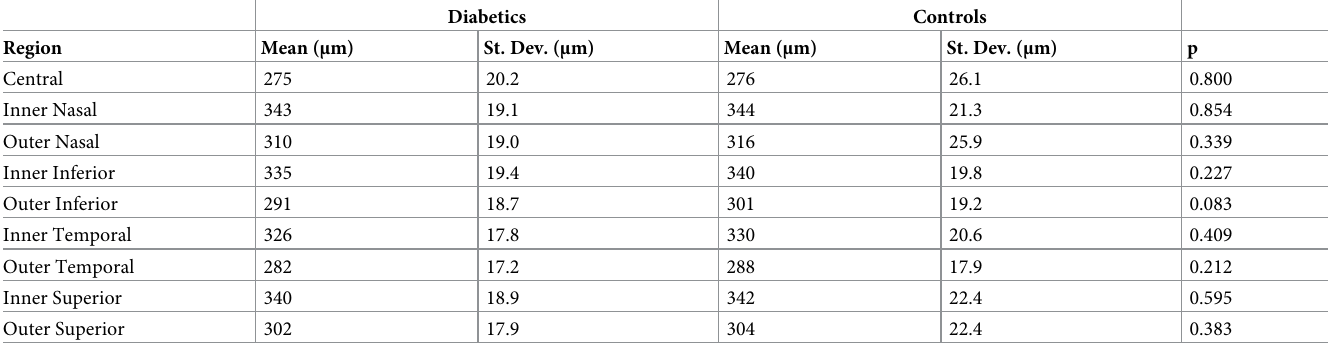
Table 1. Retinal thicknesses and standard deviations for ETDRS regions. Diabetics